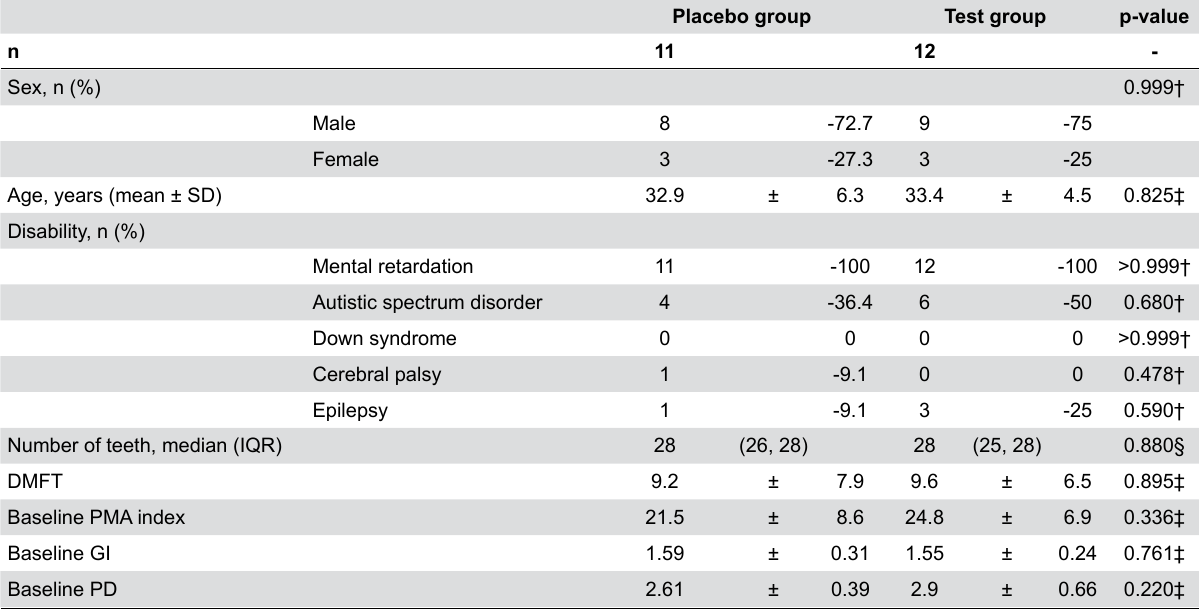
Table 1- Baseline demographic and dental characteristics of individuals with intellectual